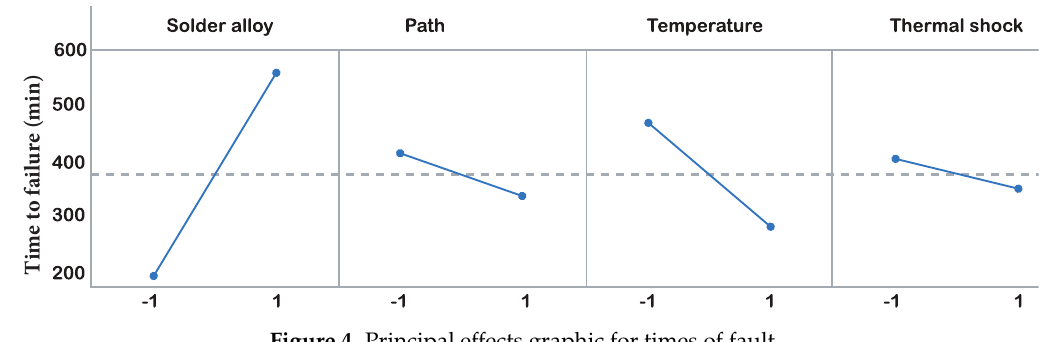
Figure 4. Principal effects graphic for times of